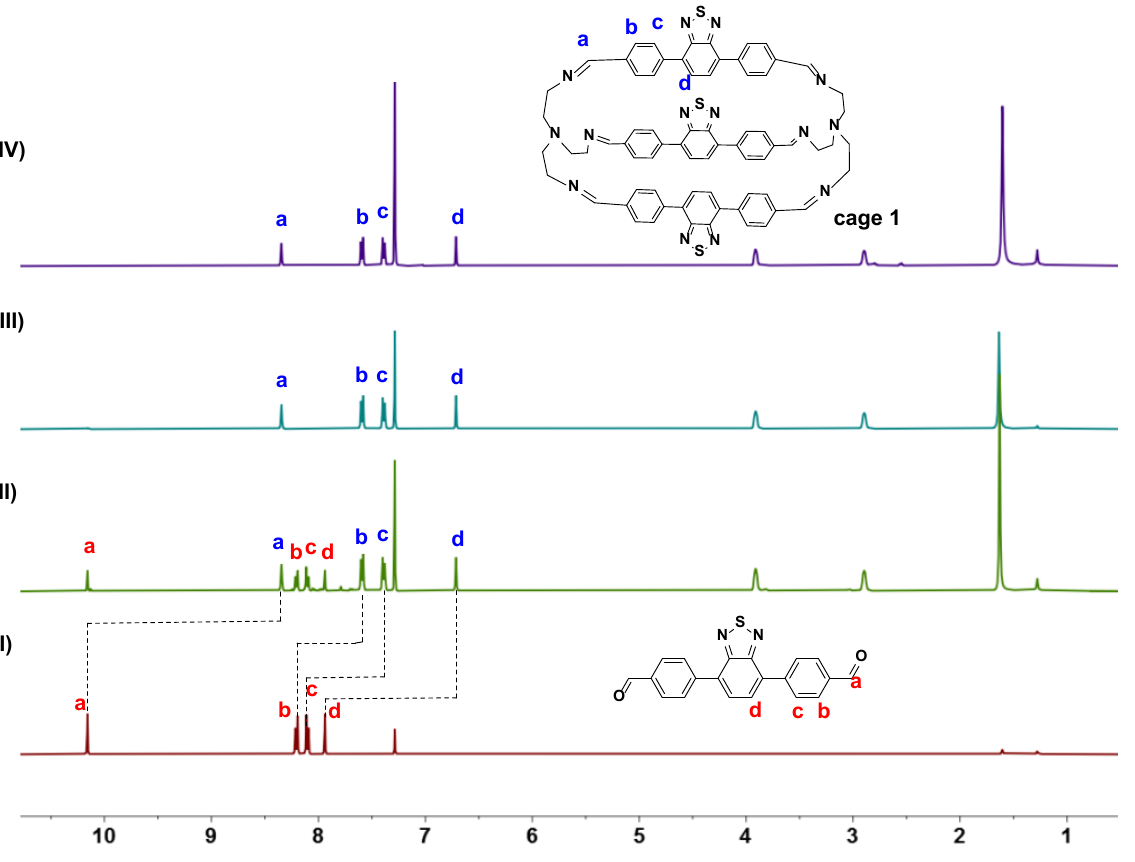
Figure 1. Partial 1 H NMR spectra (400 MHz, CDCl 3 , 298 K) of 2 (spectrum ( I )), the self-assembled products by combining 2 (7.5 mM) and TREN (5.0 mM) (spectrum ( II )), by combining 2 (6.0 mM) and TREN (4.0 mM) (spectrum ( III )), and by combining 2 (3.0 mM) and TREN (2.0 mM) (spectrum ( IV )). All spectra were recorded after mixing the corresponding starting materials for 12 h at room temperature, in order to allow the systems to reach equilibrium. Red a, b, c, and d are the associated proton signal of precursor 2. Blue a, b, c, and d are the associated proton signal of cage 1.